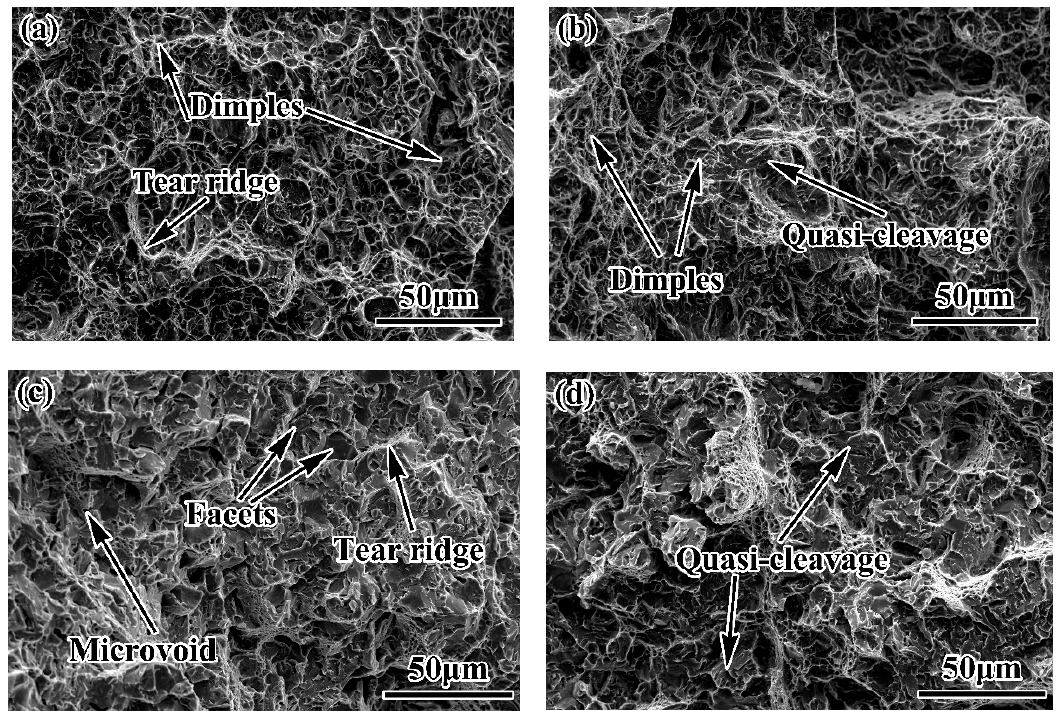
Figure 5. Fracture morphologies of the test steels tempered at different temperatures: ( a ) 200 °C; ( b ) 260 °C; ( c ) 300 °C; ( d ) 400 °C.